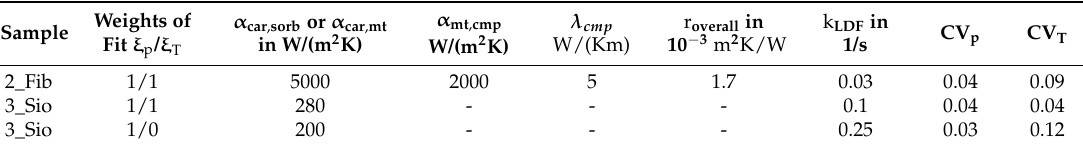
Figure 7. Identified heat transfer parameters ( a ) and mass transfer parameter ( b ) for inert-LTJ measurements and the LPJ adsorption measurement of sample 2_Fib. For each measurement, a minimum (left bar), a mean (middle bar) and a maximum (right bar) value for the identified set of heat transfer parameters is given in the left plot. The results labelled with “inert” are based on the newly-introduced inert-LTJ measurements. These data are also listed in Tables 7 and 8. The labelling of the x-axis includes the number of the corresponding step in the measurement and simulation procedure in Figure 4. For all given parameters the best fit for both the p- and T-signal was selected. This is the minimum of the objective function in Equation (21) for equal weights ξ p and ξ T . Table 9. Parameters of the best fit for sample 2_Fib and 3_Sio.